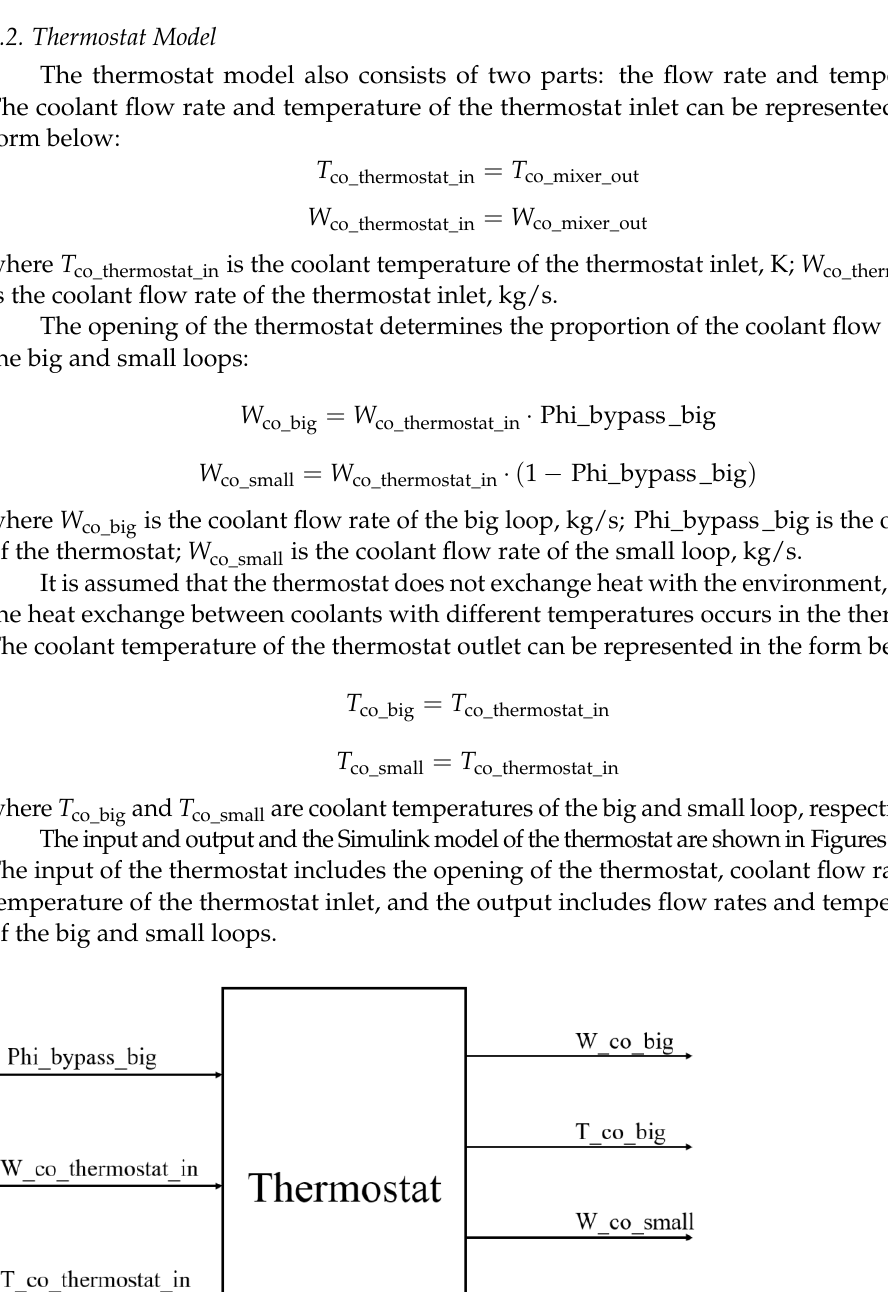
Figure 5. The Simulink model of the thermostat. 3.3. Radiator Model The flow rate of the radiator is equal to that of the big loop, and it can be represented in the form below: